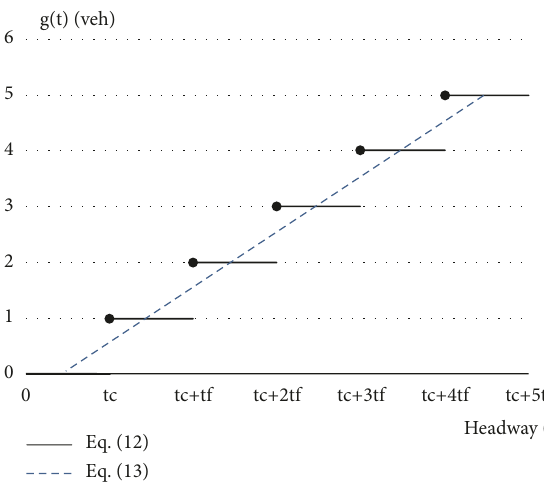
Figure 2: The g(t) of continuous function and piecewise